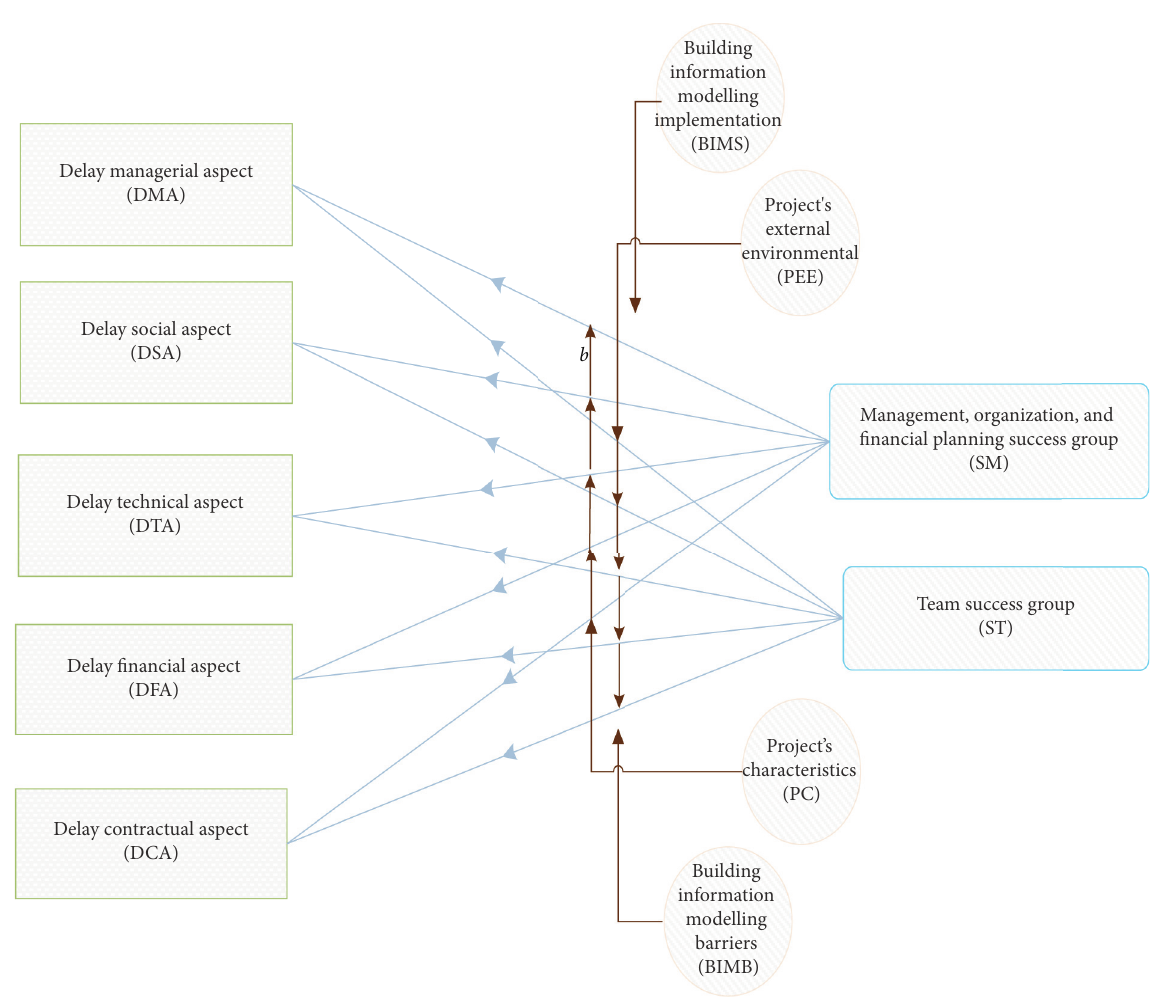
Figure 3: Conceptual model for success factors and employer-caused delay factors with moderators of BIM implementation strategy factors and BIM barrier